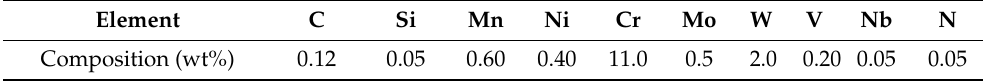
Table 1. Chemical composition of PNC-FMS (target composition).